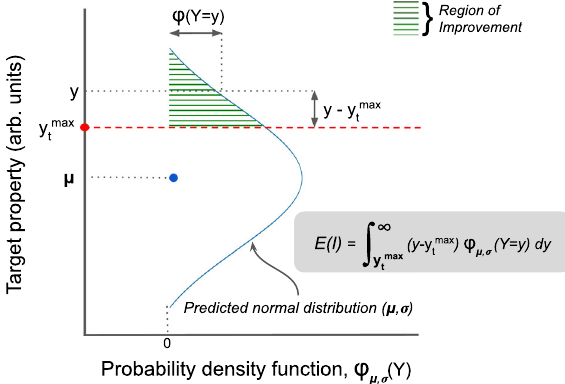
Fig. 4 The optimization algorithm. The value y max represents the t currently available highest value of ϵ among all materials in the training-data. μ and σ represent the mean and standard deviation of the ANN-ensemble predicted distribution of ϵ for a material (blue dot) in the search-space. Within the predicted distribution, which is assumed as a normalized Gaussian function here, the region above y max represents the region of improvement — as shown in green. If t the ab initio DFPT calculation determines that the material's ϵ value exists within the green-shaded region, it will be considered as an improvement over the current best value y max in training-data. t